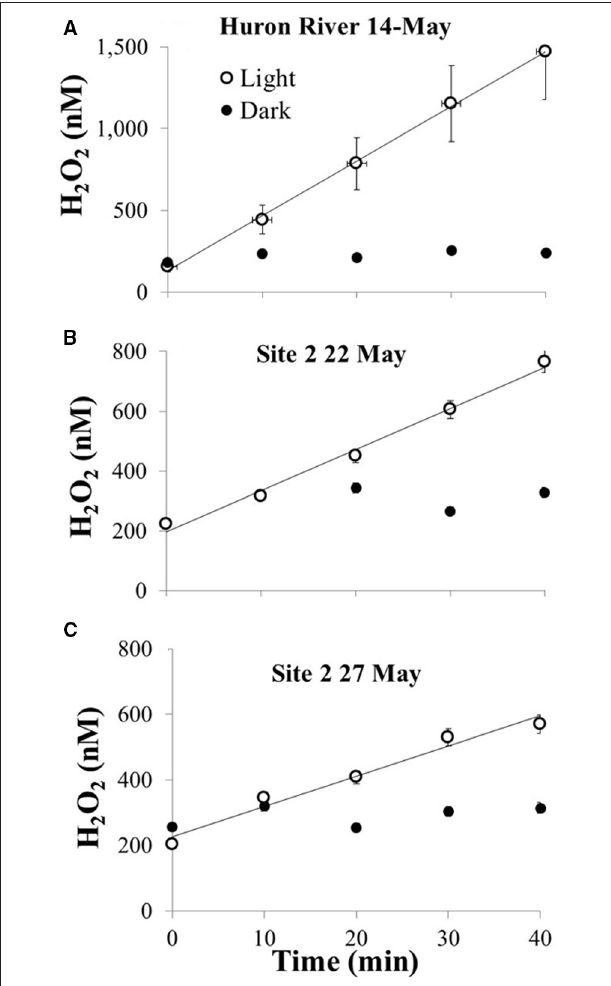
FIGURE 3 | Photochemical production of H 2 O 2 from 0.2 µ m filtered water collected in May 2014 for (A) river that drains into Lake Erie, (B) Lake Erie site 2 collected on 22 May, and (C) Lake Erie site 2 collected on 27 May. All waters were exposed to simulated sunlight in the laboratory alongside foil-wrapped dark controls; water temperatures were between 20 and 23 ◦ C for light-exposed and dark